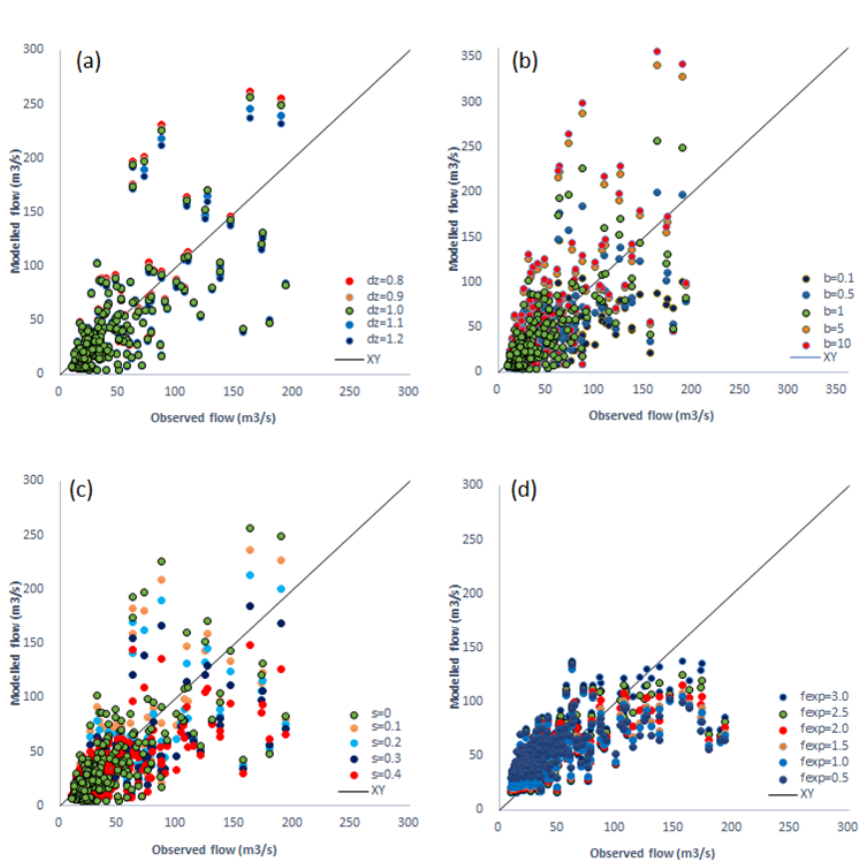
Figure 2. Sensitivity analysis of daily mean flow in the lower basin with (a) soil depth, (b) shape factor, and (c) threshold of minimum soil water content, using PDM, and (d) decay parameters, using